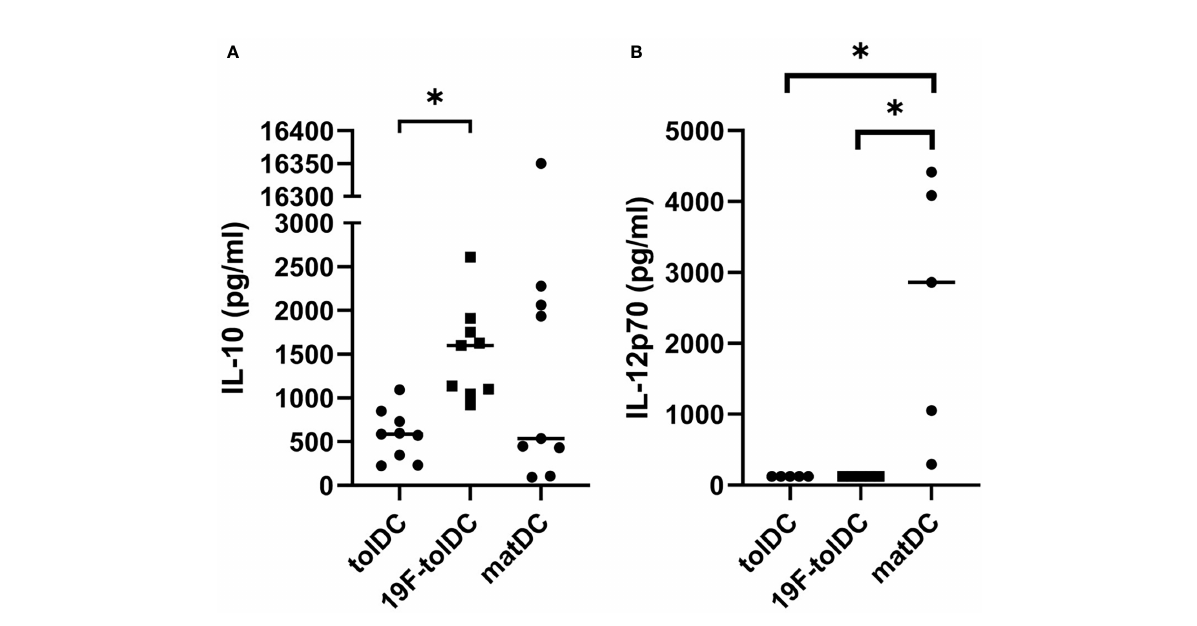
FIGURE 3 Cytokine secretion by tolDC and 19 F-tolDC. 19 F-NP (2.2 mg/ml) was added to tolDC for the last 20-24 hours of culture, after which cell-free supernatant were harvested and frozen at -80°C. Supernatants were thawed and levels of the QC cytokines IL-10 (A) and IL-12p70 (B) were assessed by ELISA. Graphs show paired experiments with a line indicating the median (*p ≤